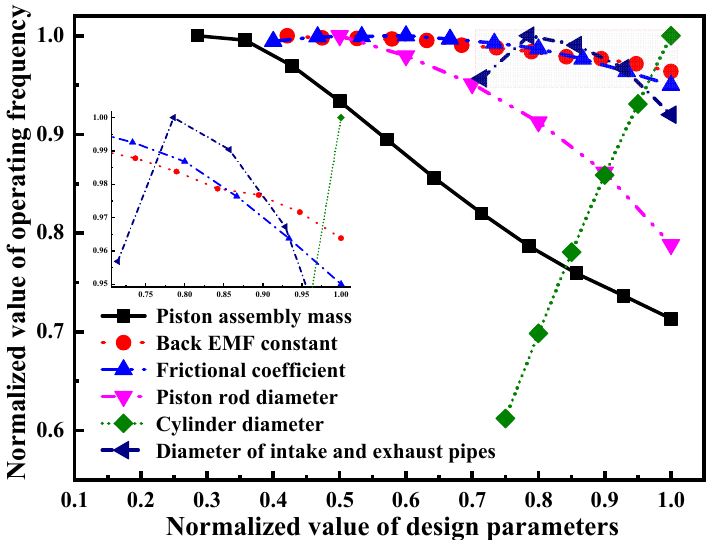
Figure 16. Influence of design parameters on power output.